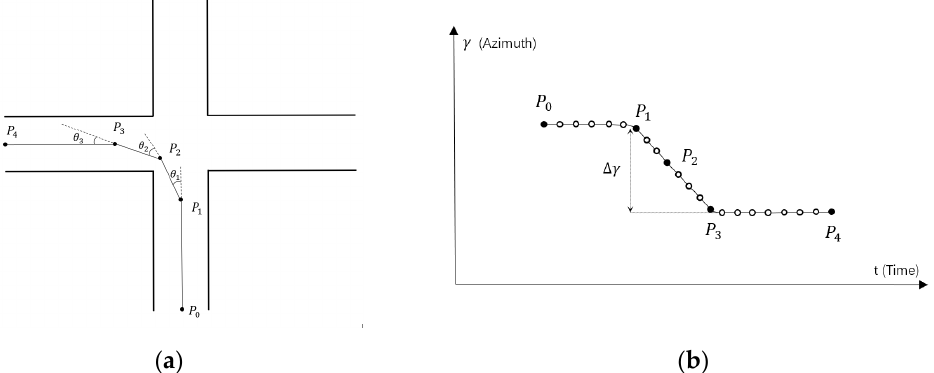
Figure 5. Diagram of determination of turning modes: ( a ) turning feature points of left turn; ( b ) azimuth angle change of the direction sensor.